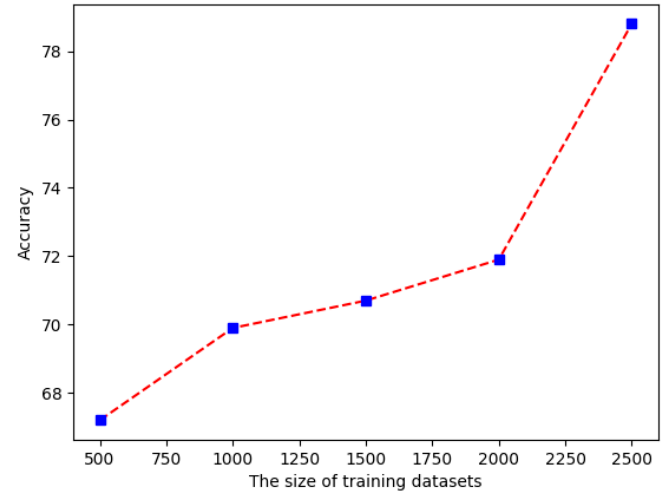
Figure 7. Increasing performance in proportion to the size of training datasets .